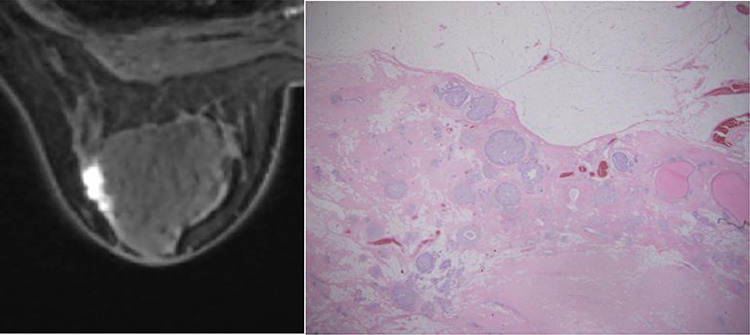
Dynamic contrast-enhanced MRI and pathological images of the primary tumor of patient #2 in Table 2 who had recurrence after 8 years follow-up. Axial view of delayed-phase (~5 min after gadolinium injection) T1-weighted image (left) shows linear enhancement toward nipple. She was diagnosed to have invasive cT1c tumor with extensive intraductal components. However, the resected specimen had intraductal components only (right).